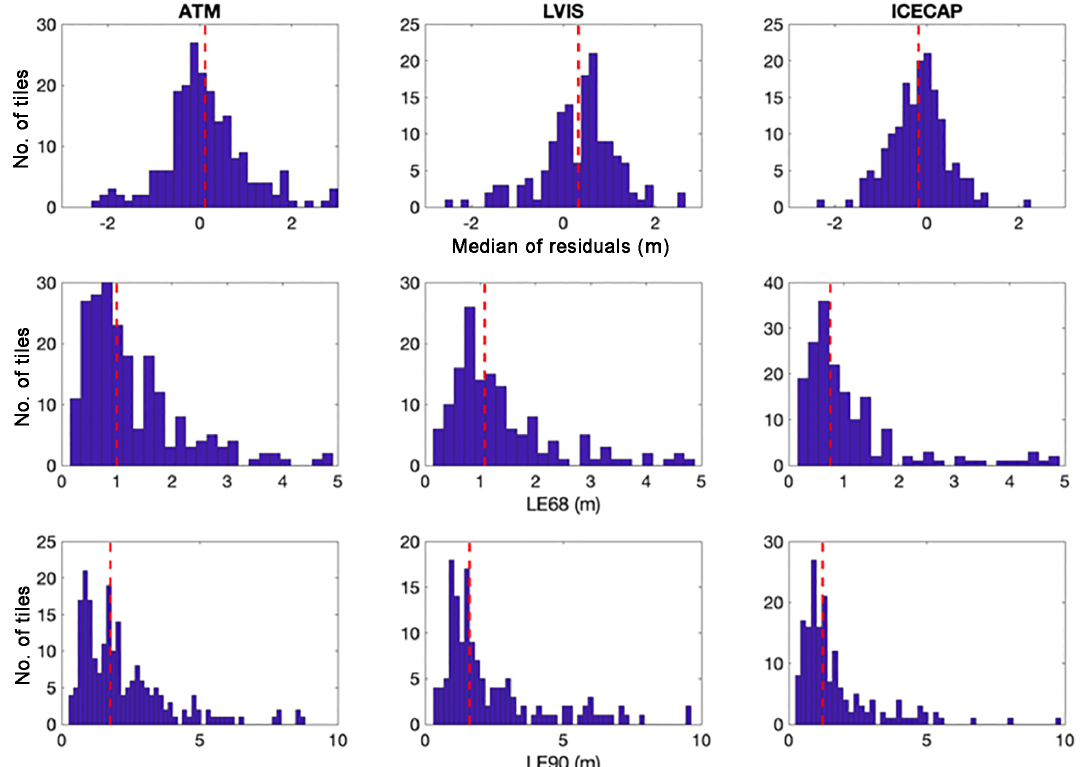
Figure 6. Validation results for mosaic tiles. Histograms of the medians and linear errors at the 68th and 90th percentiles (LE68 and LE90) obtained from the differences between each REMA tile and the three NASA OIB airborne laser altimeters. The altimeter elevations are subtracted from the REMA elevations, so that a positive median of residuals (top plots) indicates the REMA surface is higher than the altimeter surface. Vertical red dashes are the median values.